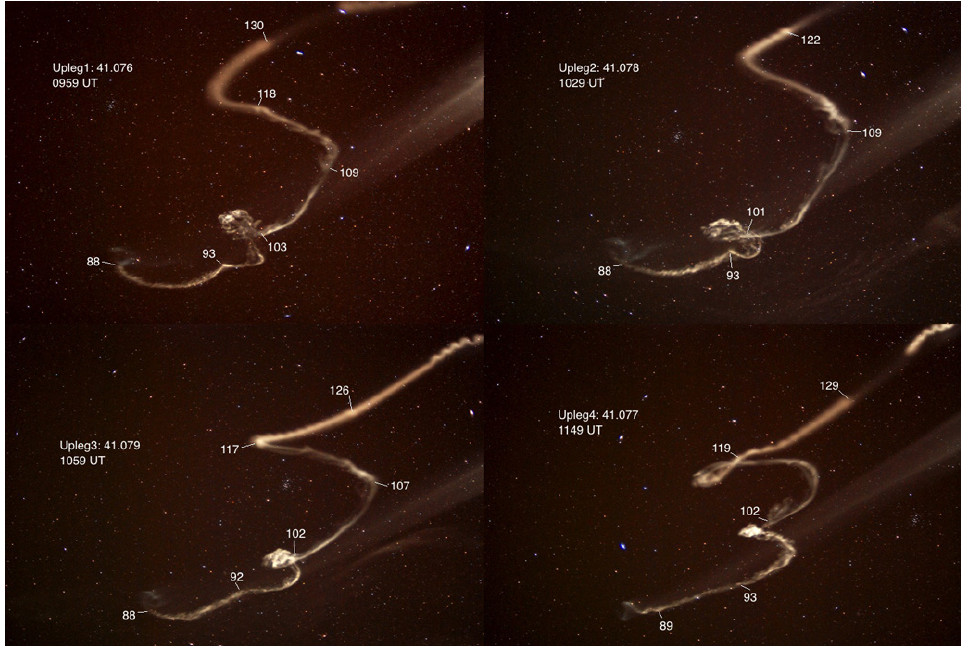
Fig. 1. Upleg trails from the four launches photographed six minutes after launch. Altitudes are marked in kilometers.